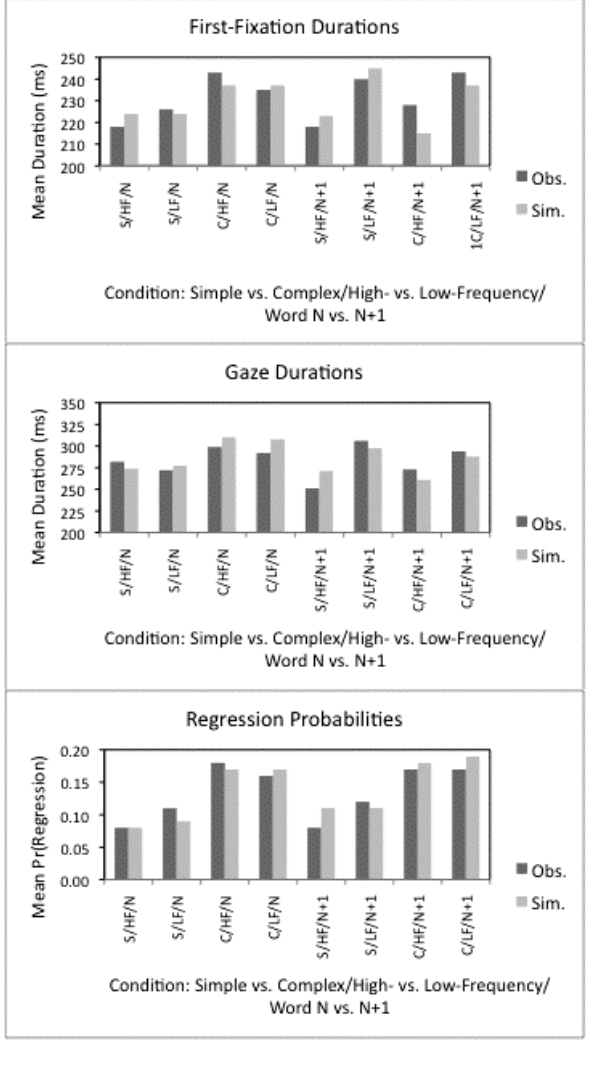
Figure 2. Observed and simulated first fixation durations, gaze durations, and regression probabilities for the critical verb (word N) and the critical adverb (word